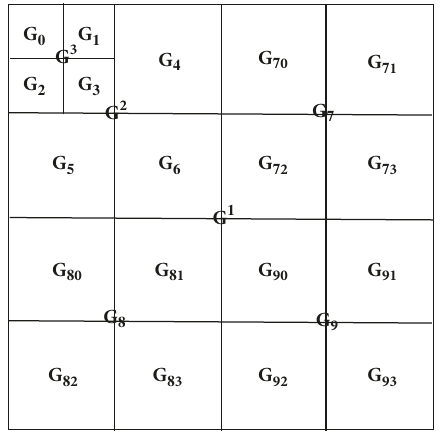
Figure 4: Reorganized Krawtchouk moment